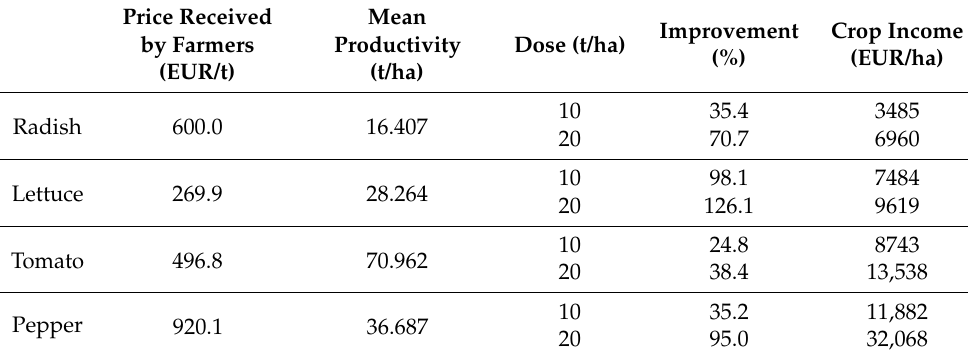
Table 7. Calculation of the crop benefit for each vegetable and biochar dose.